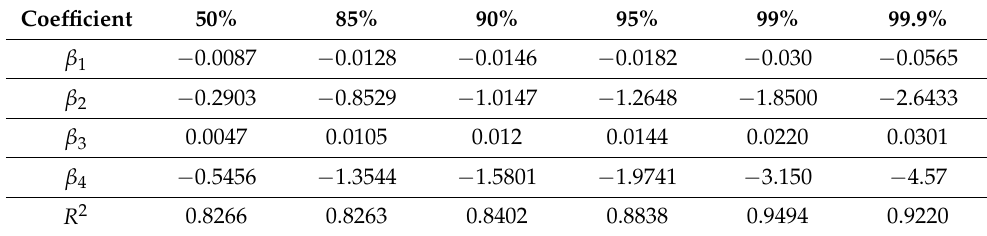
Table 4. The linear fit result of the